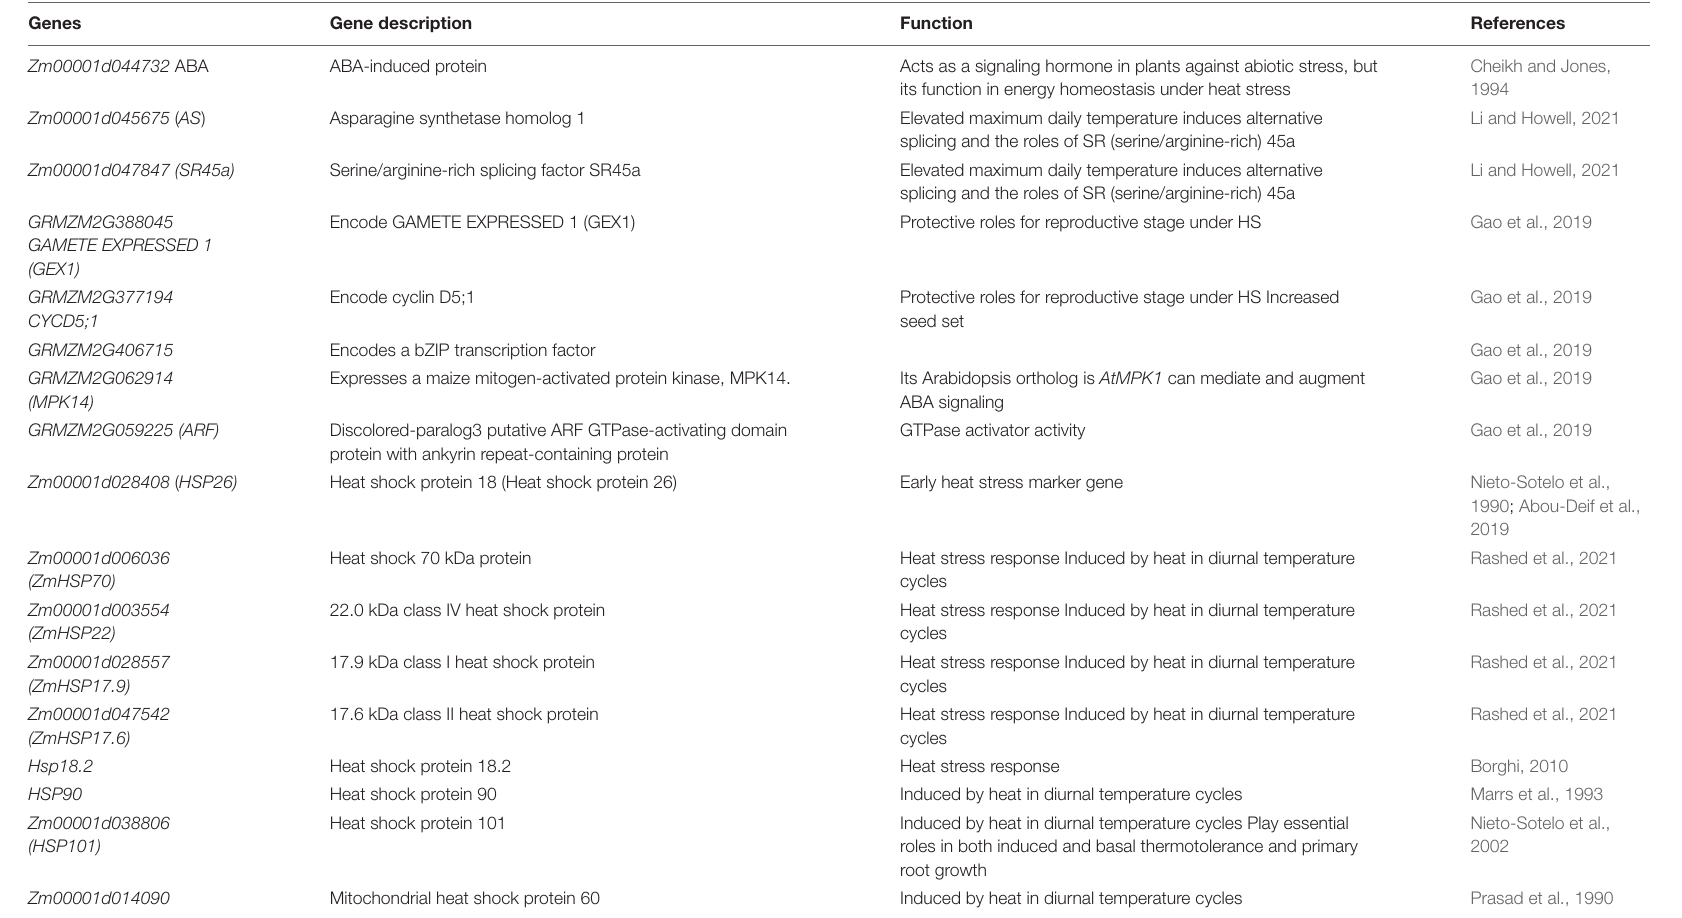
TABLE 2 | Key genes related to heat stress mechanisms.